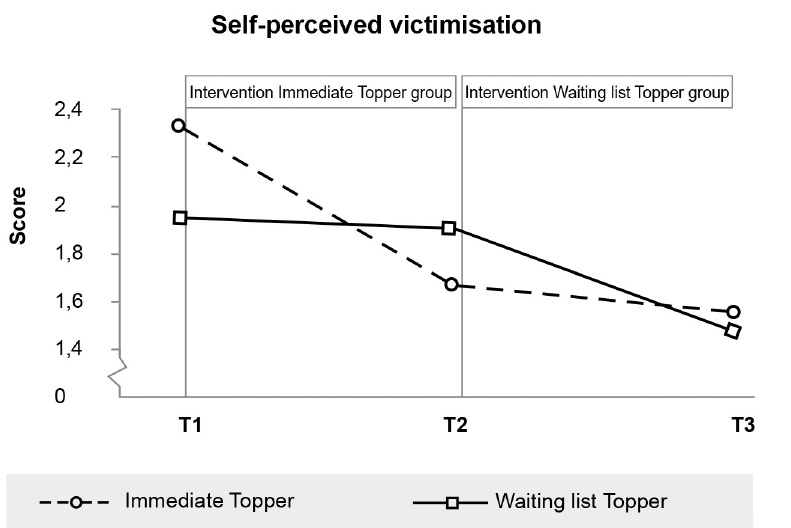
Fig 7. Significant effect of Topper Training on self-perceived peer